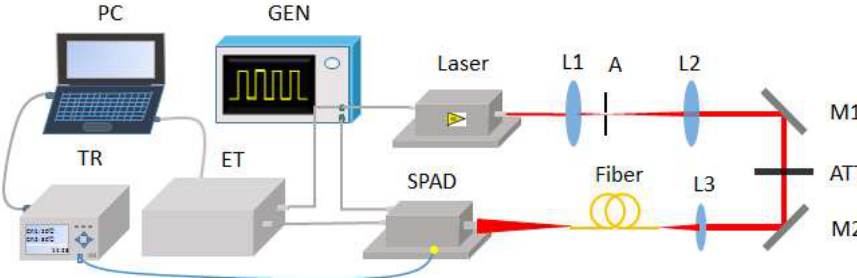
Figure 1. Experimental setup of the laser time transfer based on the temperature drift post-compensation. GEN is a generator; L1, L2 and L3 are planoconvex lenses; A represents the aperture; M1 and M2 are high-reflection mirrors; ATT is an attenuator; SPAD is a single-photon detector based on Si; ET is an event timer (precision: 8 ps); and TR is a temperature recorder.